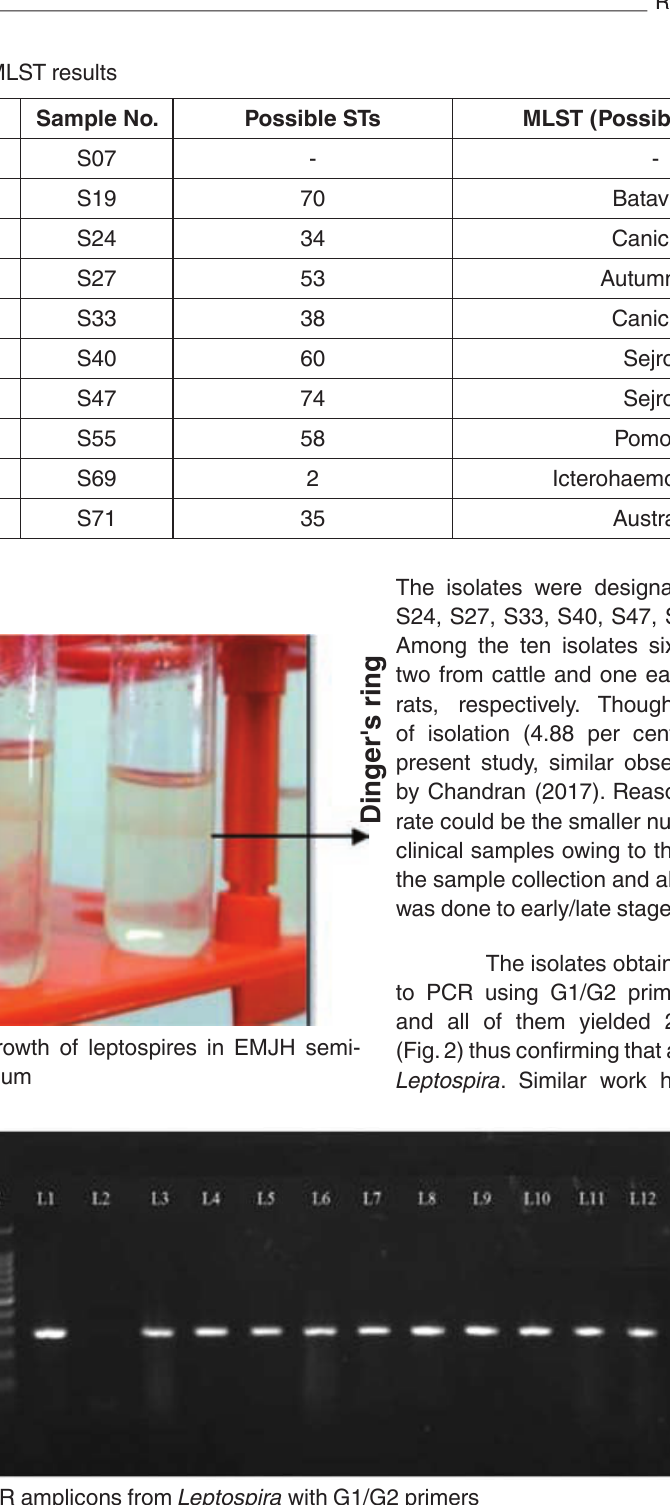
Fig. 2. PCR amplicons from Leptospira with G1/G2 primers Molecular marker : 100 bp